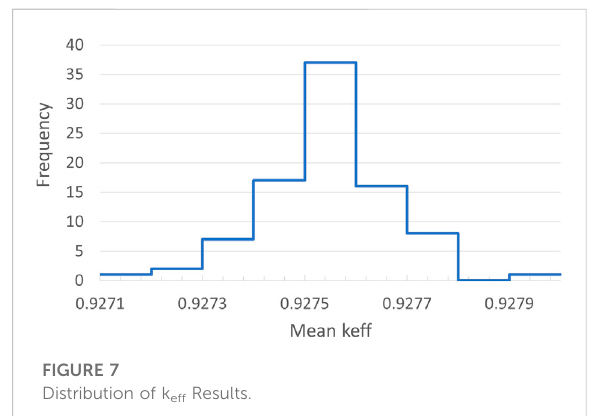
FIGURE 7 Distribution of k eff